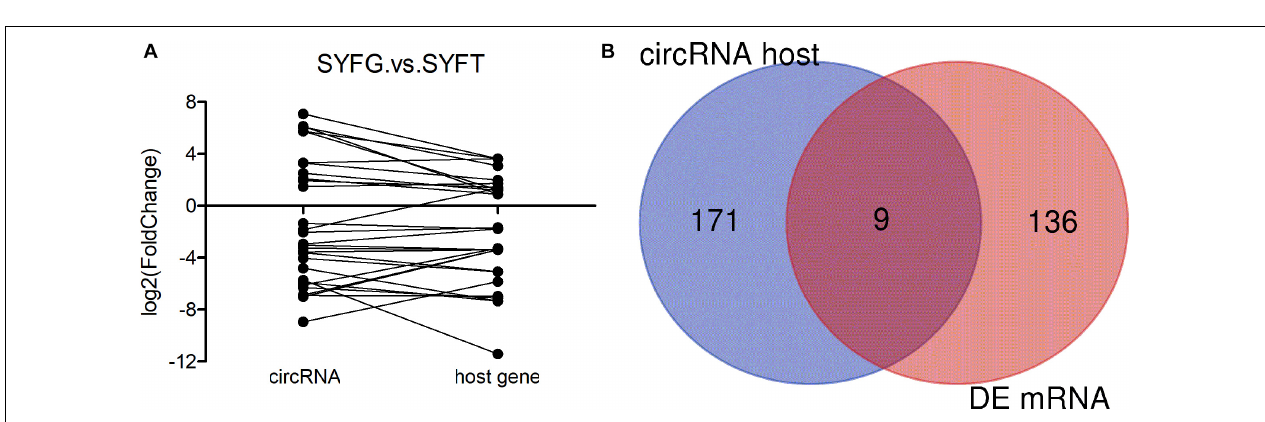
FIGURE 2 | Differentially expressed circRNAs in venn diagram and heatmap. (A) Venn diagram of differentially expressed circRNAs; (B) heatmap of 207 pervasive circRNAs in three follicular development stage. SYF, small yellow follicle; F6, the smallest hierarchical follicle; F1, the largest hierarchical follicle. GCs, granulosa cells; TCs, theca cells.